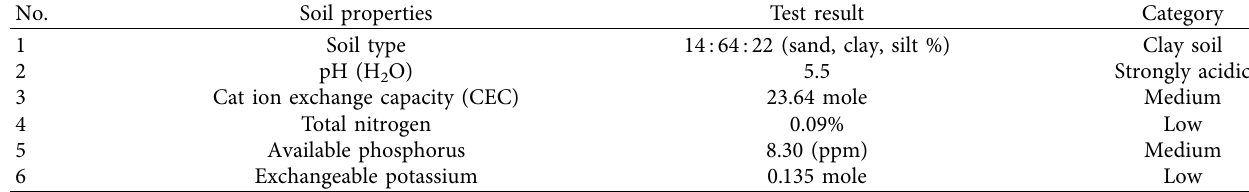
Table 1: Former soil characteristics of the experimental site.